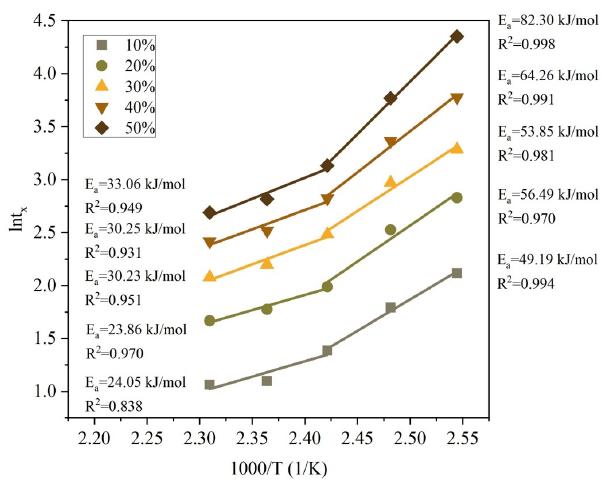
Figure 9. Dependence of lnt x on 1000/T for various degrees of recovery of copper.